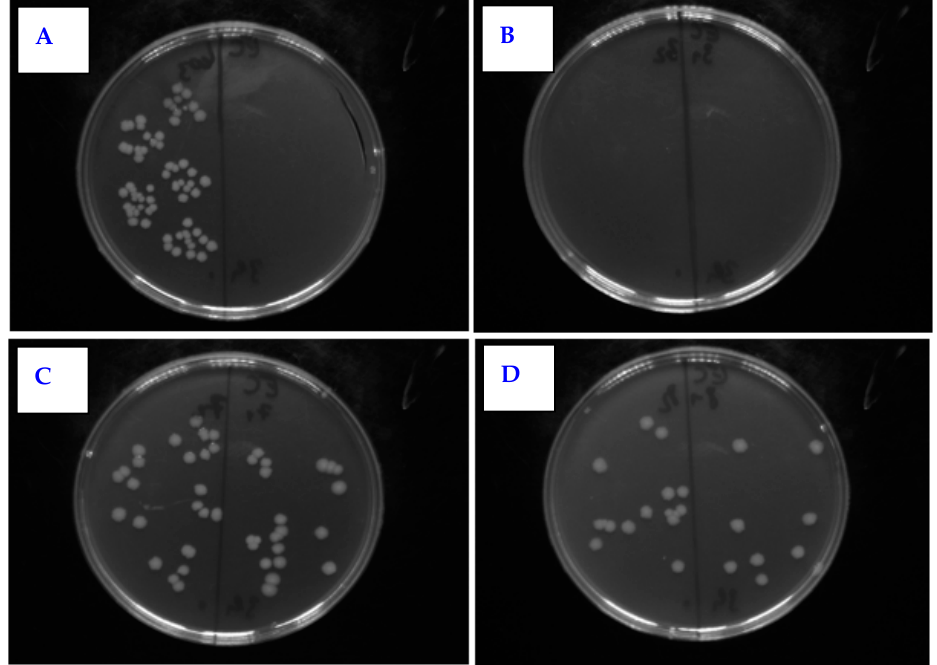
Figure 17. Selected photos of agar plates from antimicrobial tests for PFA against E. coli for samples: ( A ) control sample; ( B ) pristine + Ag 240 s; ( C ) plasma 8 W 240 s; ( D ) plasma 8 W 240 s + Ag 60 s.